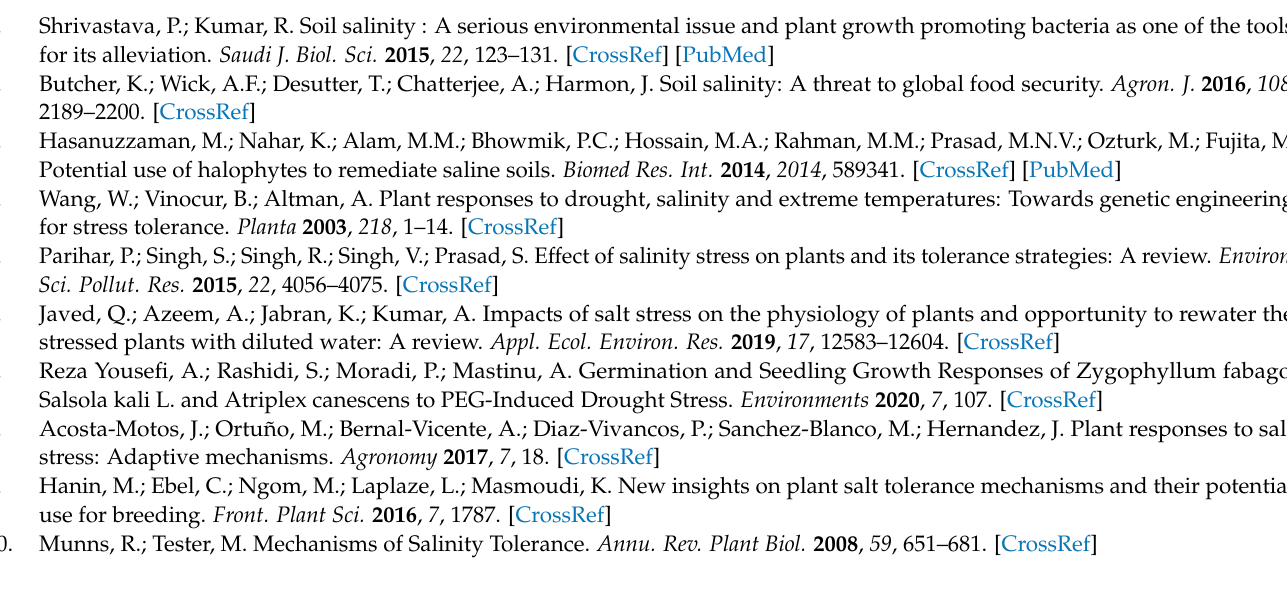
Figure S2: Subsystems of predicted genes in D. abyssi MT1.1 T genome using RAST